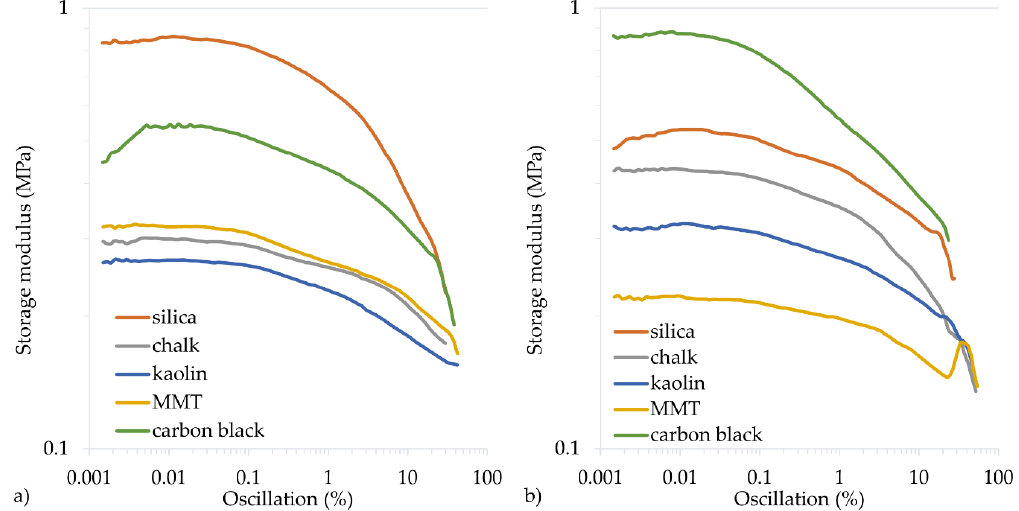
Figure 6. Storage modulus of filled CR cross-linked with copper(I) oxide ( a ) or copper(II) oxide ( b ); T = 160 °C, t = 45 min.